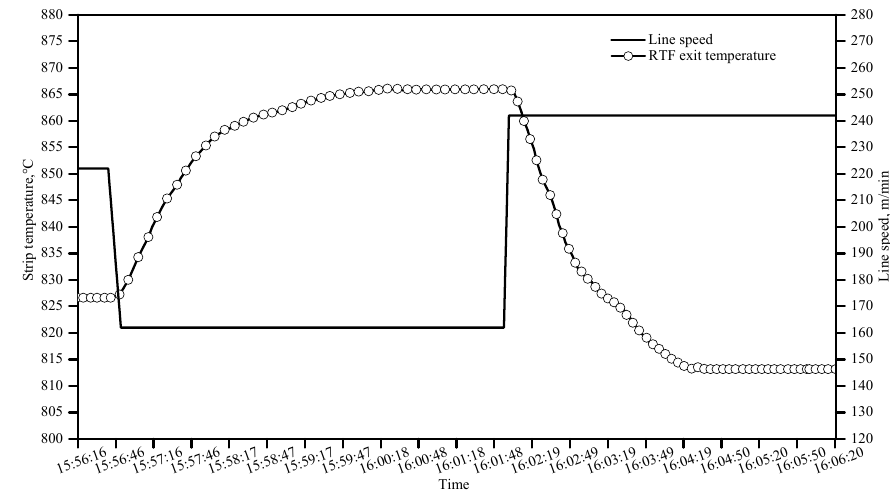
Figure 7. Response of strip temperature at RTF exit when line speed changes.